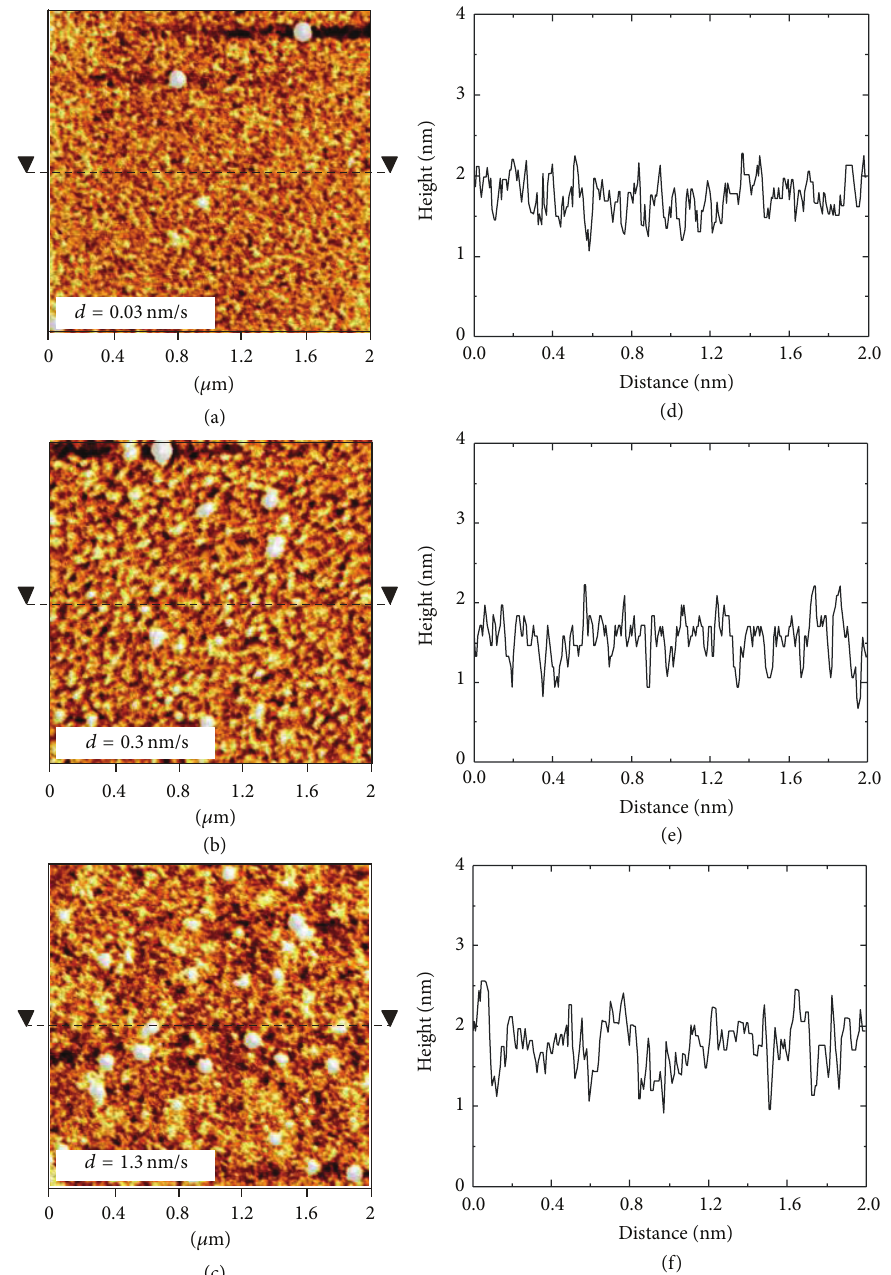
Figure 4: The atomic force microscope micrographs of Bebq 2 (5nm) films prepared with different deposition rates of (a) 0.03, (b) 0.3, and (c) 1.3 nm/s on the bulk material of Bebq 2 (55nm; 1.3nm/s) substrate. The depth profiles of ultrathin Bebq 2 with three deposition rates of 0.03 (d), 0.3 (e), and 1.3 (f) nm/s were extracted from the centerline of corresponding